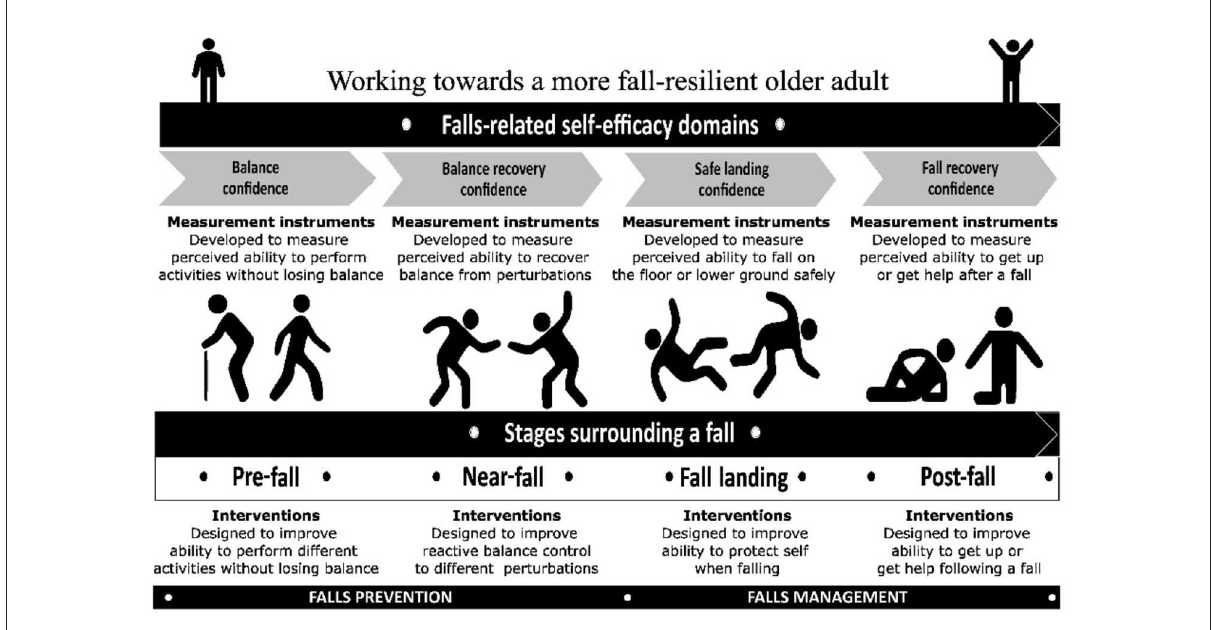
FIGURE1 The various domains of falls efficacy and the different stages surrounding a fall. The figure has been adapted and reproduced with permission (15).